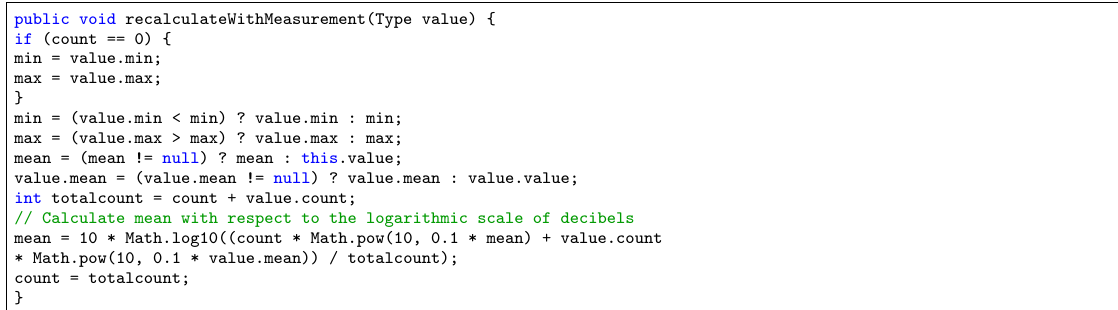
Figure 8. Method that performs the aggregation when a new measurement is added.